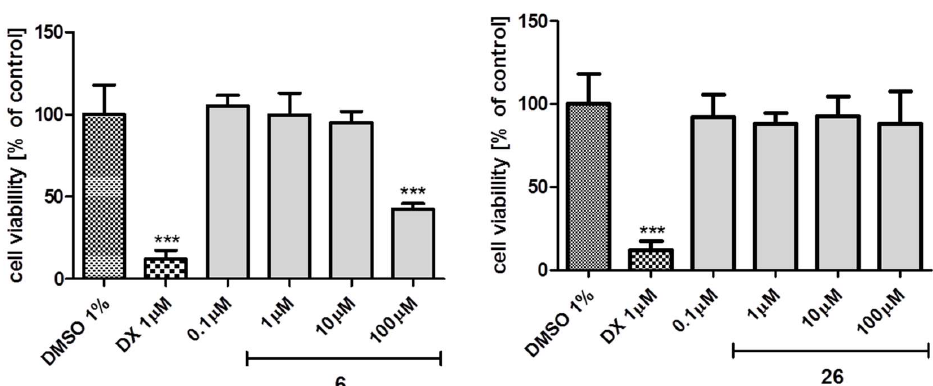
Figure 7. The influence of doxorubicin (DX) and 5-HT6R ligands on the viability of cultured HEK-293 cells. Statistical significance was evaluated by one-way ANOVA, followed by Bonferroni’s comparison test (*** p < 0.001 compared with the negative control).